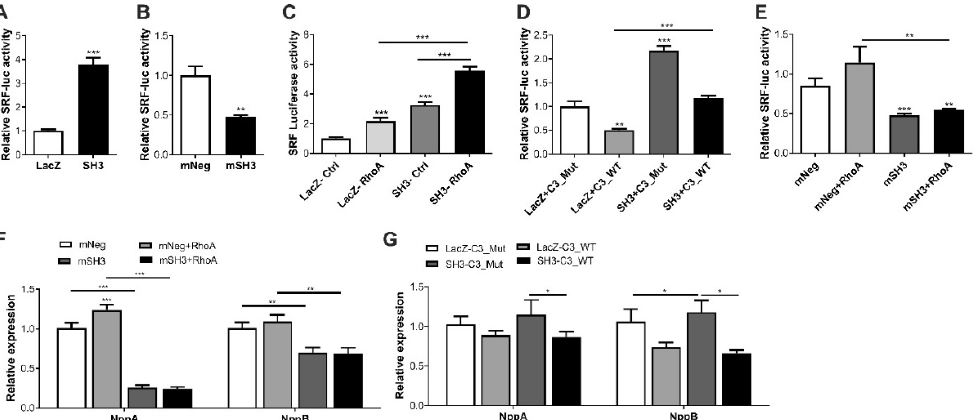
Figure 3. Effect of SH3BGR on SRF signaling-SH3BGR overexpression significantly induced SRF response element-driven luciferase activity ( A ), whereas its knockdown resulted in the inhibition of luciferase activity ( B ). Interestingly, luciferase activity in the presence of RhoA was significantly higher for SH3BGR than LacZ or SH3BGR alone ( C ), whereas the pres- ence of C3 transferase, a RhoA inhibitor, significantly attenuated SH3BGR-mediated luciferase activity ( D ). Similarly, SH3BGR knockdown abrogated the activation of SRF luciferase activity due to RhoA ( E ). These effects were also reflected